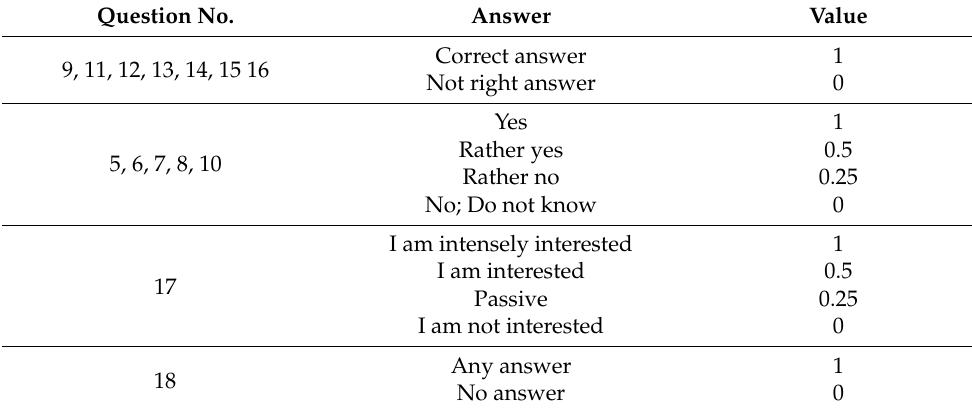
Table 2. The evaluation of individual answers.